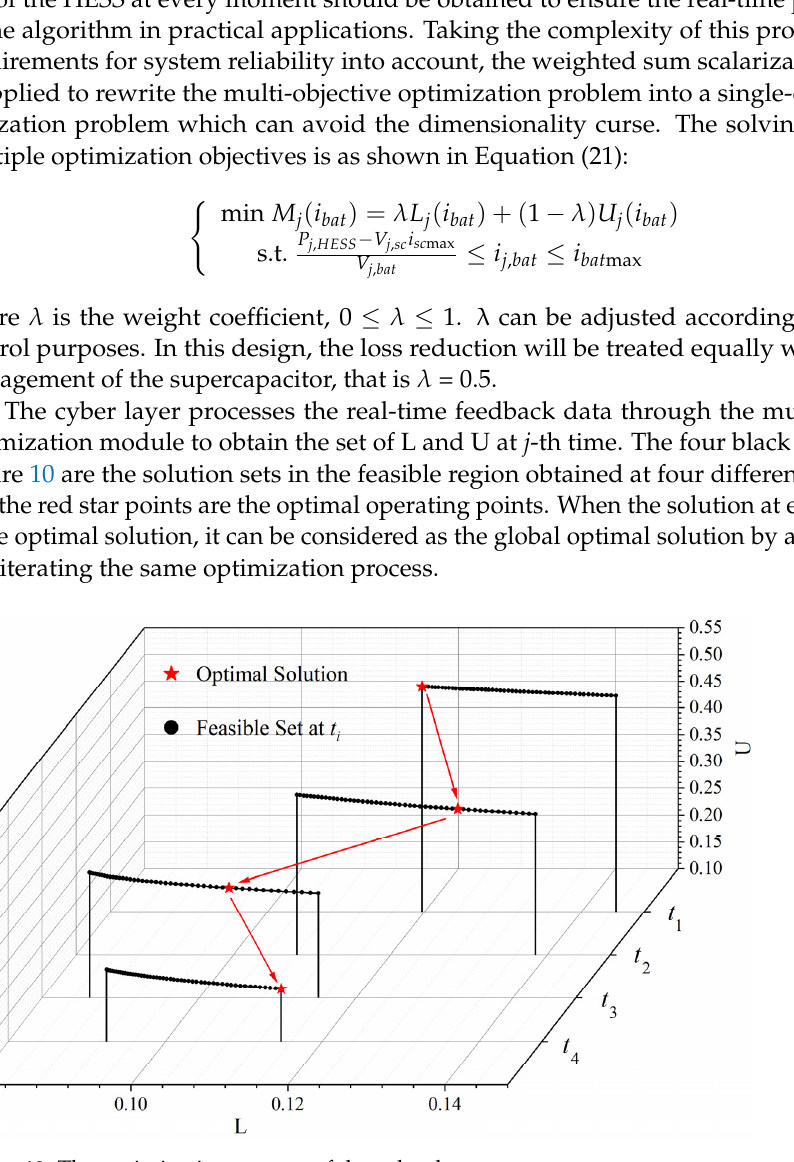
Figure 10. The optimization process of the cyber layer.